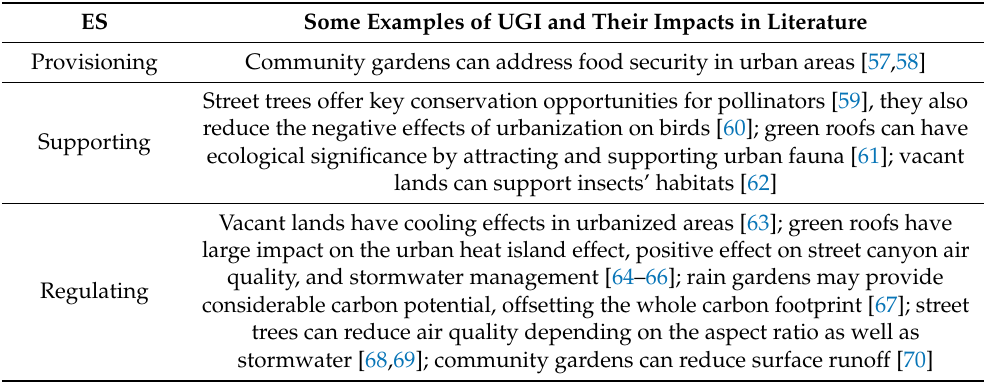
Table 1. Urban ES provided by six studied small-scale green